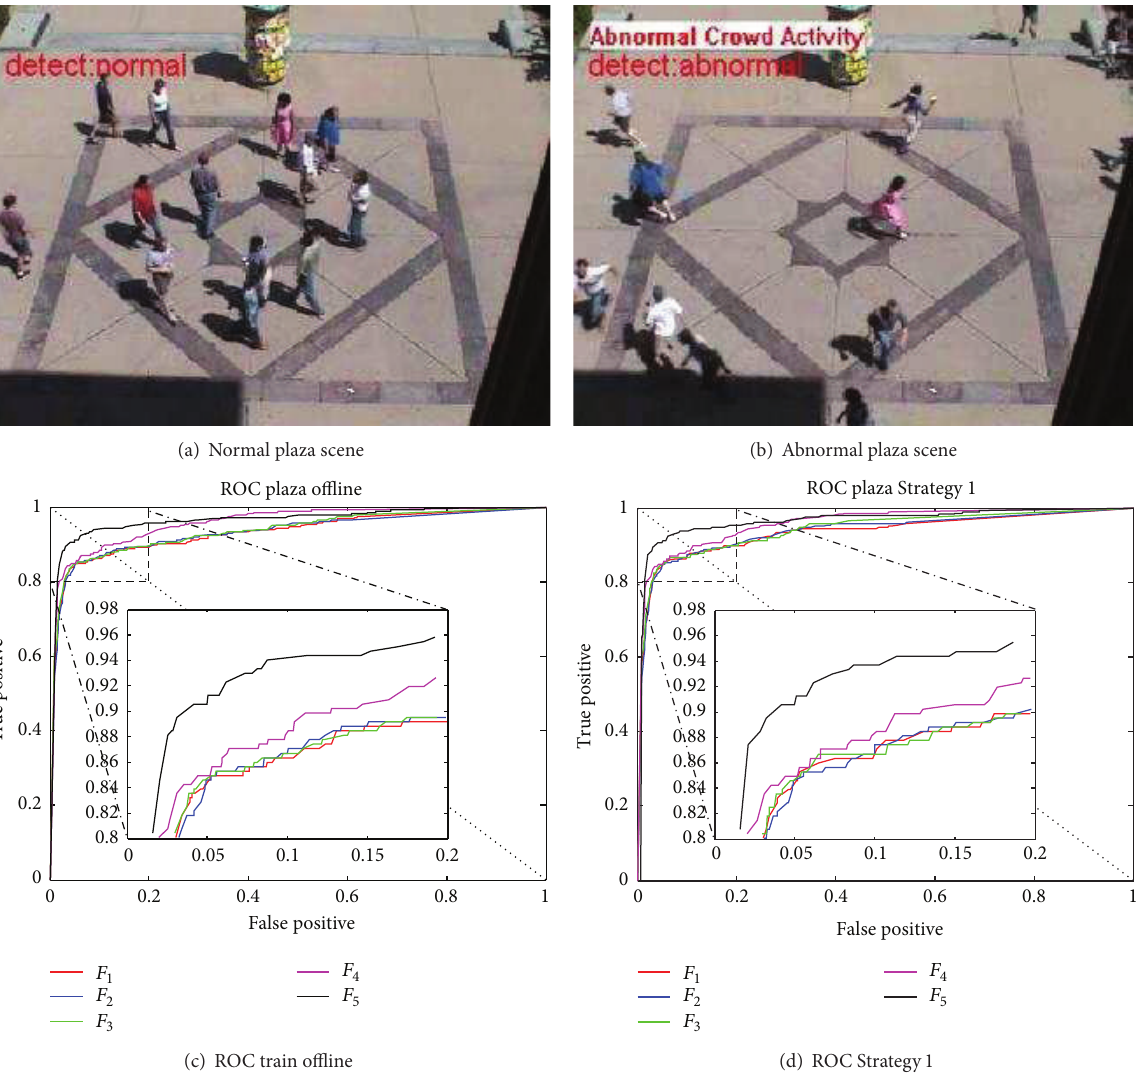
Figure 7: Detection results of the plaza scene. (a) The detection result of one normal frame. (b) The detection result of one abnormal panic frame. (c) ROC curve of different features 𝐹 of the plaza scene results via one-class SVM. All the training samples are learned together offline. The biggest AUC value is 0.9649. (d) ROC curve of different features 𝐹 results via Strategy 1 online one-class SVM. The biggest AUC value is